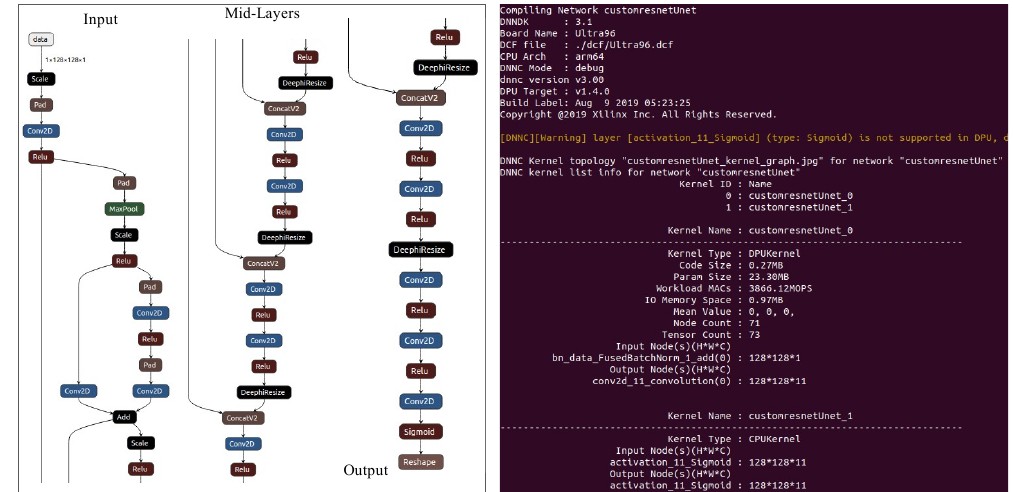
Figure 16. Deployment Model (from quantization stage) and Compiled Network Summary by